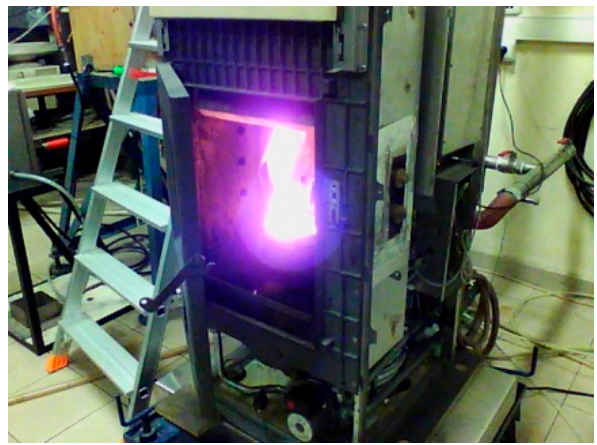
Figure 4. Biomass pellet combustion inside the boiler.